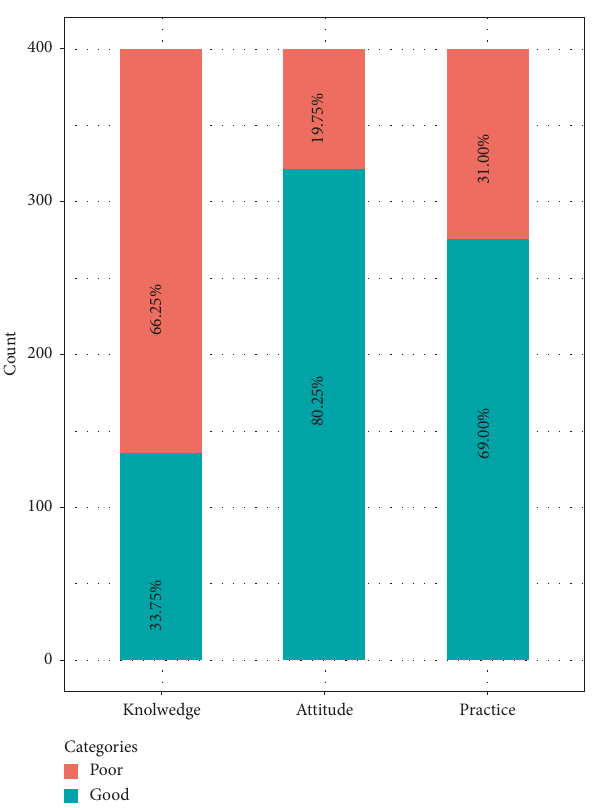
Figure 3: Distribution of knowledge, attitude, and practice categories among respondents.